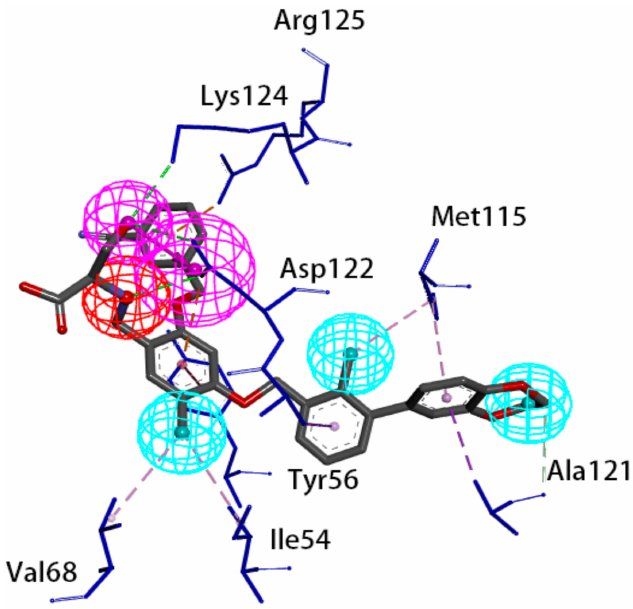
Figure 9. Superposition between BMS-1001 and the pharmacophore model. As the figure shows, the positive ionizable point is red, the hydrophobic point is blue, and the hydrogen bond donor is purple. The interacted residues of PD-L1 are blue.